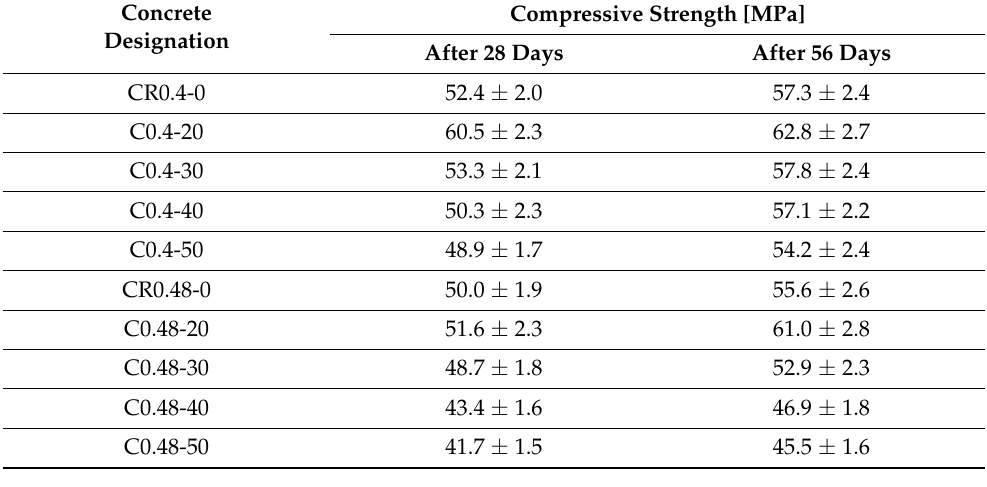
Table 5. The results of UWC compressive strength testing.